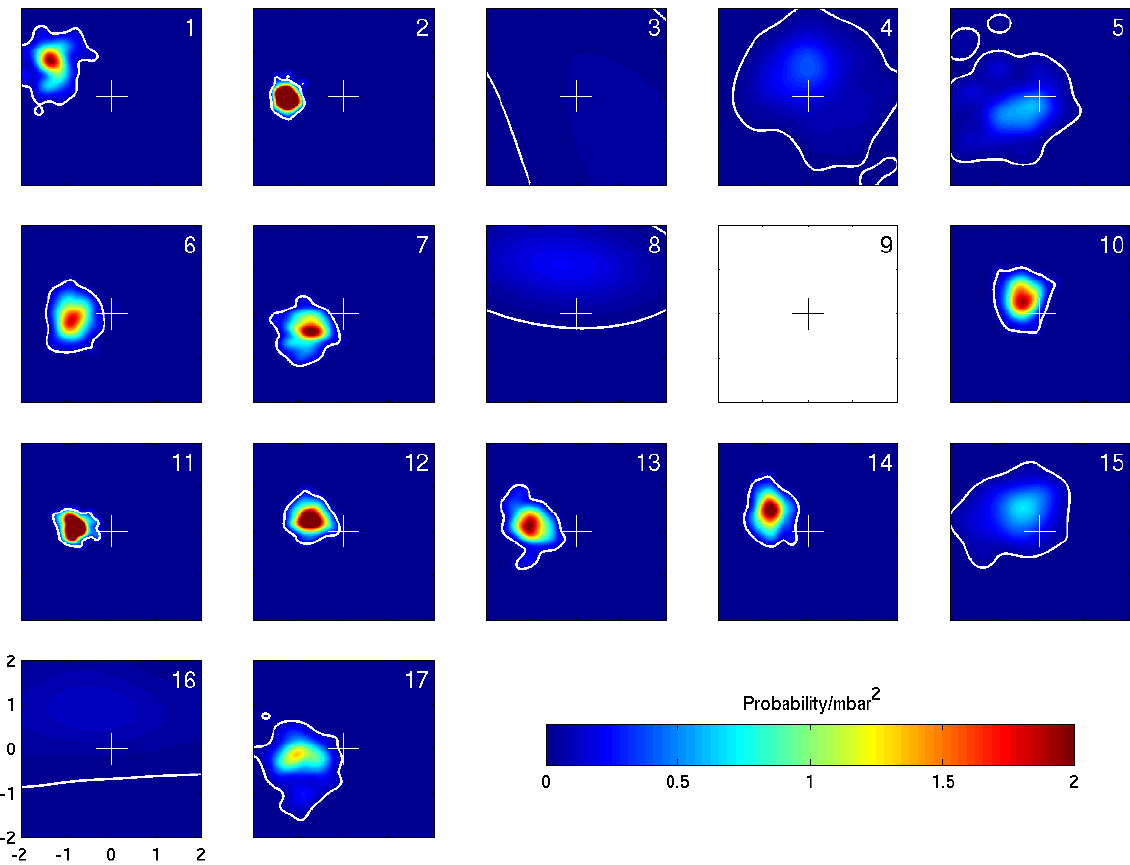
Figure 7. Probability density functions (PDFs) for the amplitude and phase of m o calculated from each site with noise added to the bottom- pressure records, and mappings F s from hydrology and atmosphere model. Convergence was too poor at site 9 to calculate a PDF; 95% of results fall inside the white contour. Subplot axes are identical to Fig.